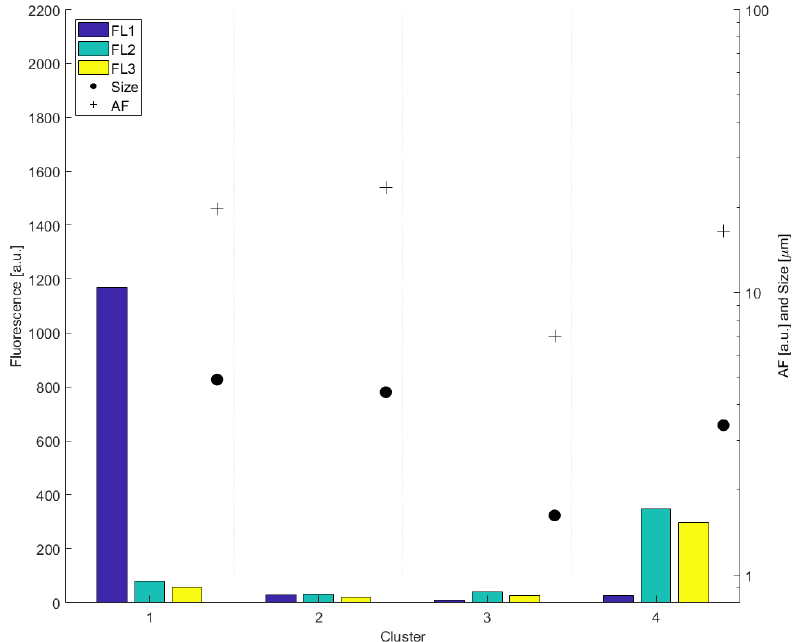
Figure A1. Summary of the average fluorescence, size and AF of each cluster from the long-term